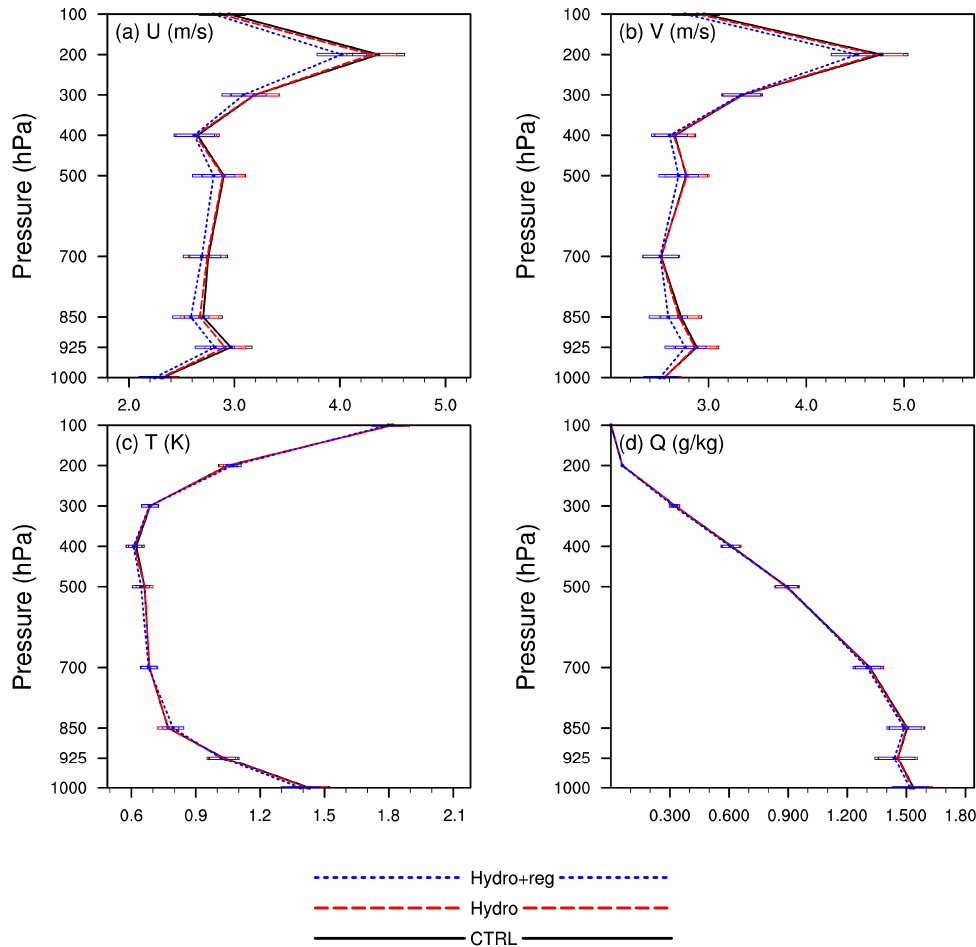
Figure 6. The 20-cycle-averaged RMSE of 3 h forecast in main precipitation area from 5 cases. ( a ) 𝑈 (units: m/s), ( b ) 𝑉 (units: m/s), ( c ) 𝑇 (units: K), ( d ) 𝑄 (units: g/kg).